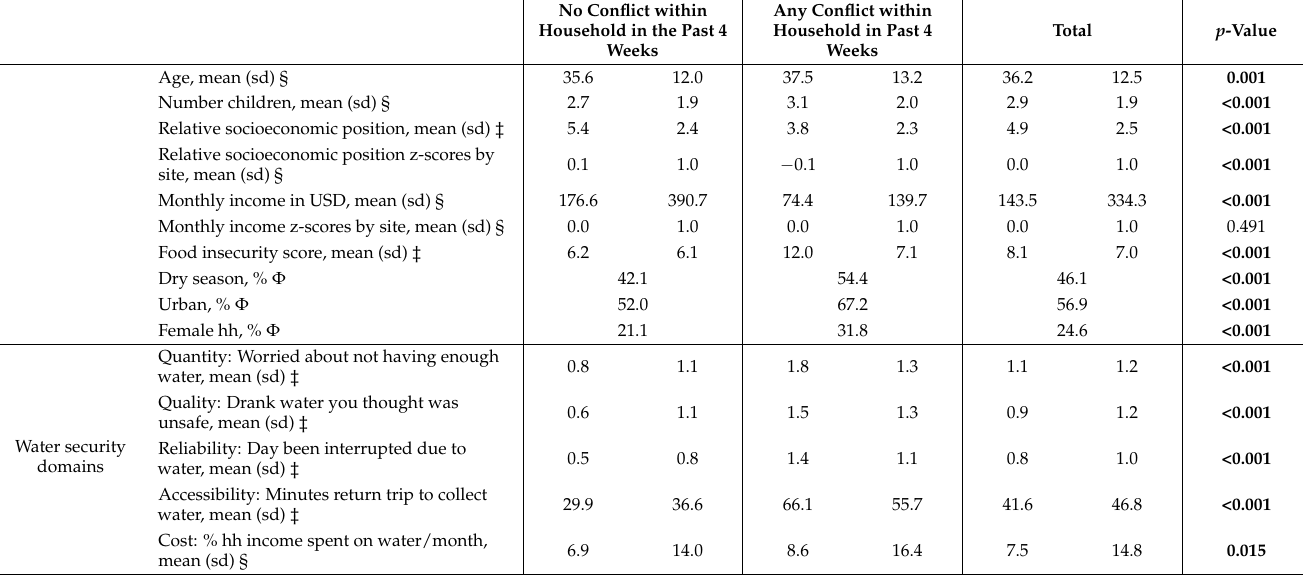
Table 3. Descriptive statistics for demographics and water insecurity domains by whether or not the household experienced internal conflict in the past four weeks. p -values are for group difference tests.